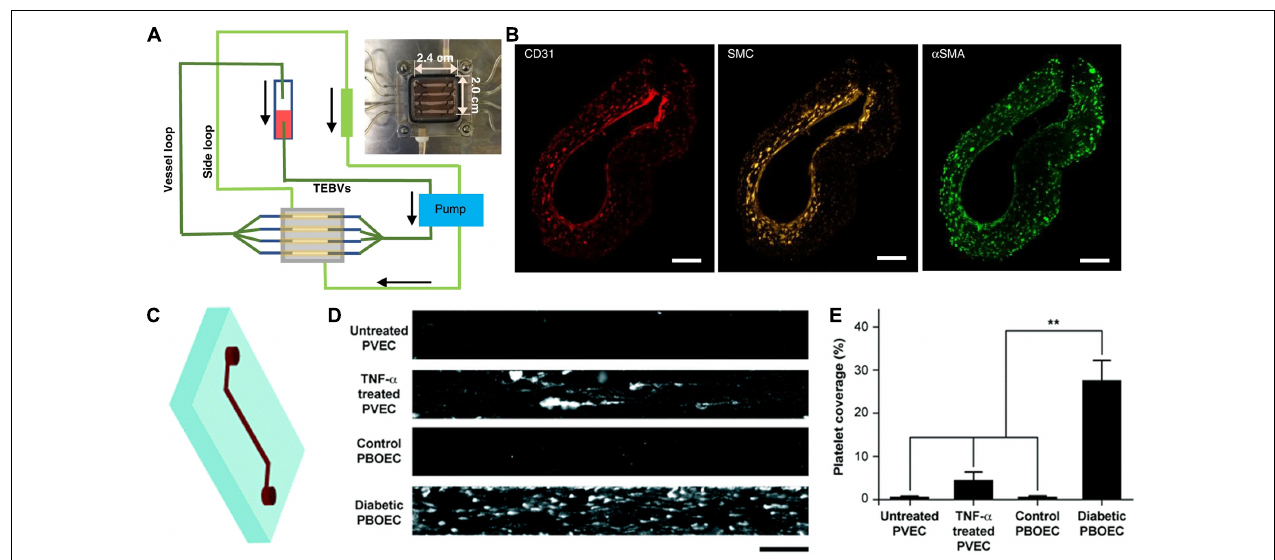
FIGURE 1 | Application of tissue chips for cardiovascular disease modeling. (A) Schematic of tissue chip composed of perfused tissue-engineered blood vessels for modeling vascular disease. (B) Immunofluorescence staining of a three-layered vascular graft comprising CD31-expressing endothelial cells, smooth muscle cells (cell tracker yellow), and smooth muscle actin ( α SMA)-expressing fibroblasts. Reproduced with permission from Zhang et al. (2020). Copyright 2020 authors licensed under a CC BY 4.0 (https://creativecommons.org/licenses/by/4.0/; Zhang et al., 2020). (C) Schematic of vessel chip. (D) Adhesion of fluorescently tagged platelets onto vessel chips seeded with porcine primary vein endothelial cell (PVEC) with or without TNF- α induction, or porcine blood outgrowth endothelial cells (PBOEC) from healthy or diabetic donors. (E) Quantification of platelet area coverage inside vessel chip after perfusion of blood (** indicates p < 0.005). Adapted from Mathur et al. (2019) with permission from the Centre National de la Recherche Scientifique (CNRS) and The Royal Society of